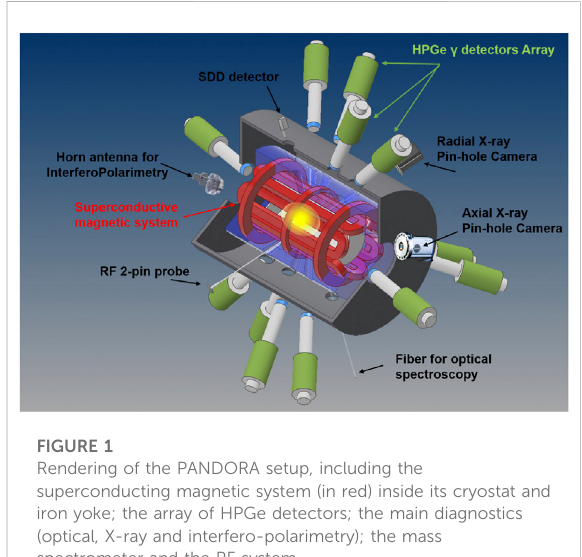
FIGURE 1 Rendering of the PANDORA setup, including the superconducting magnetic system (in red) inside its cryostat and iron yoke; the array of HPGe detectors; the main diagnostics (optical, X-ray and interfero-polarimetry); the mass spectrometer and the RF